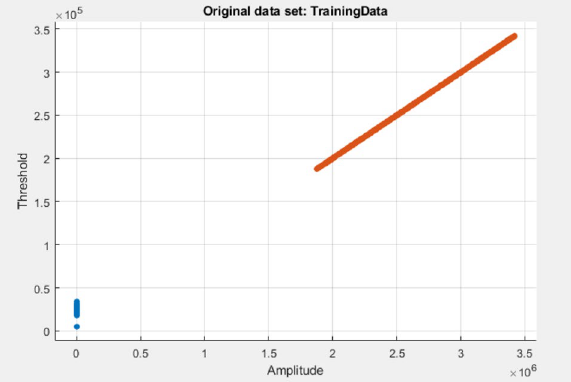
Figure 9. ENSEMBLE scatter